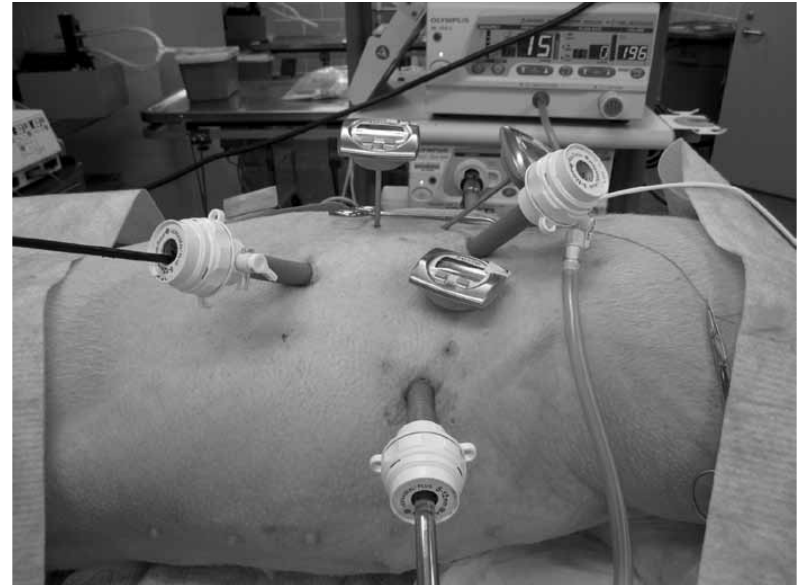
Figure 1 - Set-up for laparoscopic ports and dual lumen ureteral catheter in the porcine model.